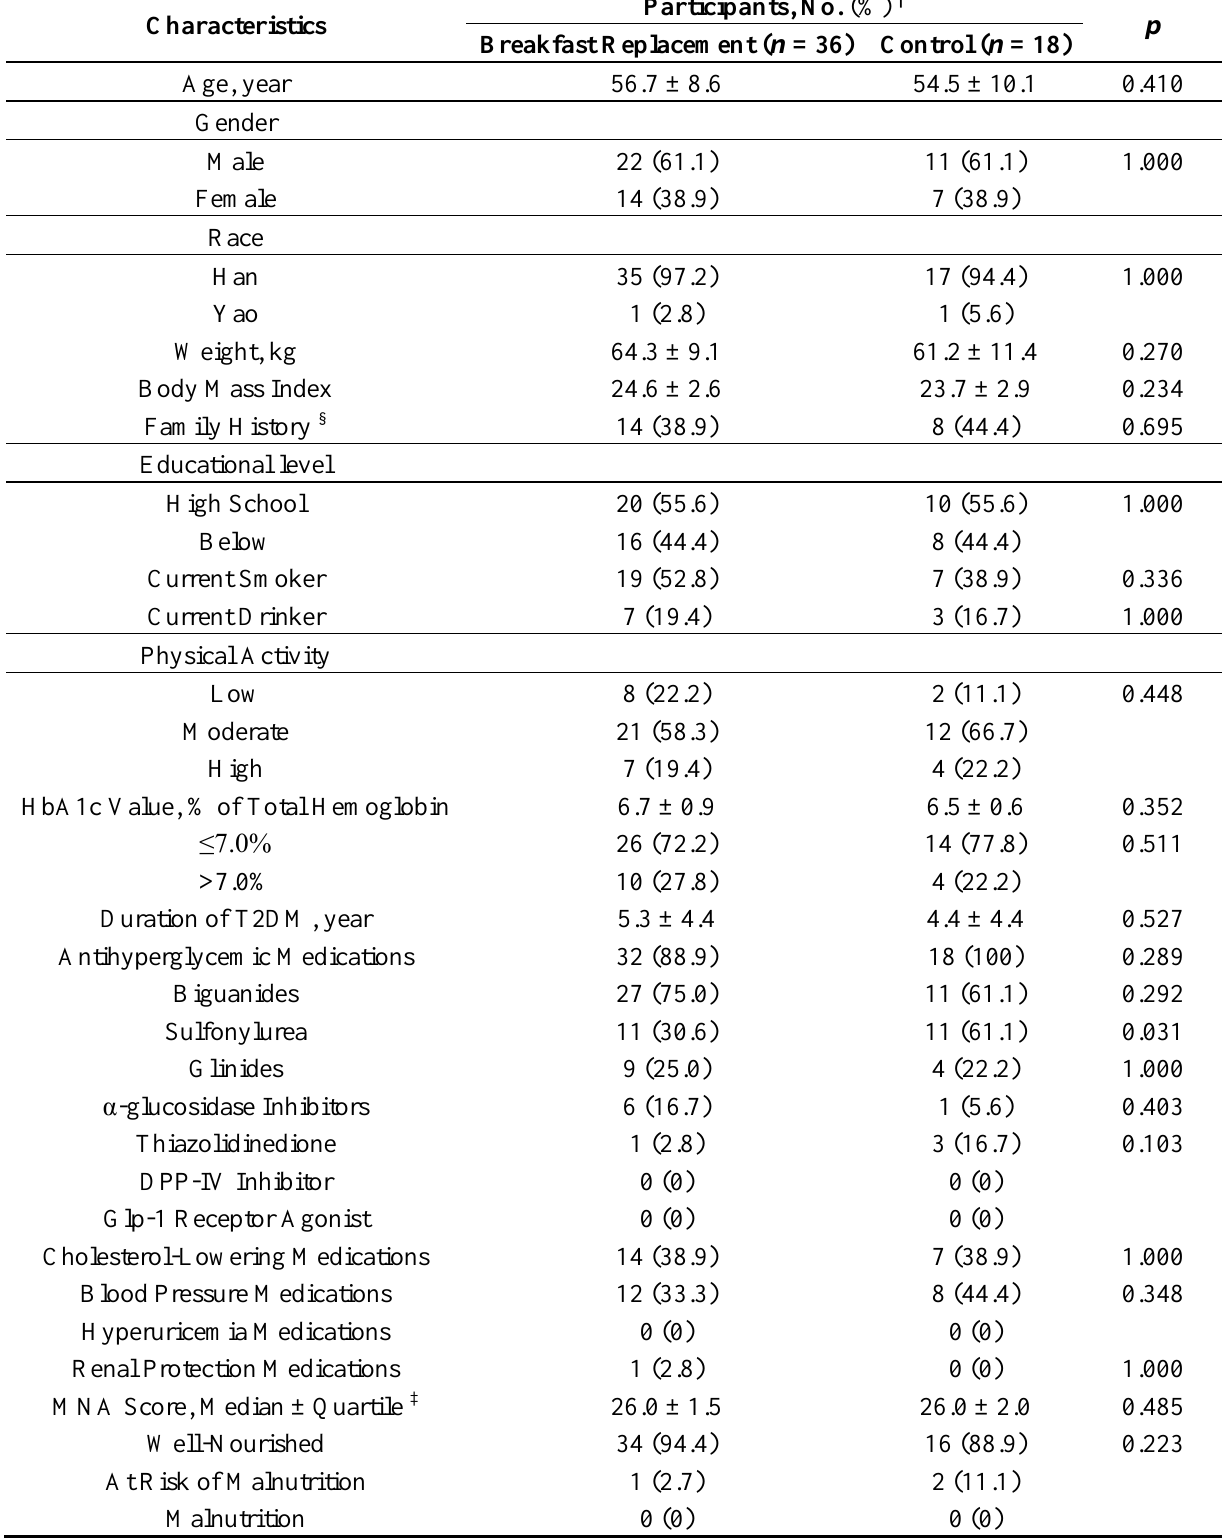
Table 1. Baseline characteristics of study